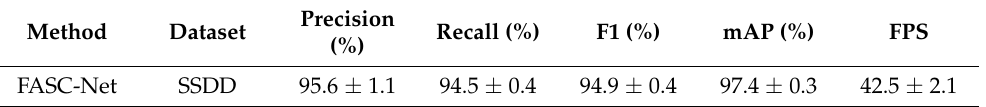
Figure 14. The F1–Confidence curve and P–R curve. ( a ) F1–Confidence curve. ( b ) P–R curve. Table 3. Experimental results on the SSDD